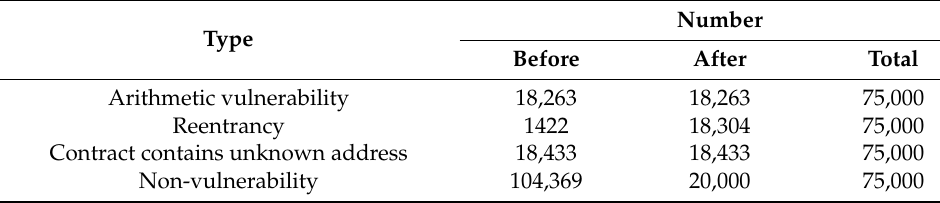
Figure 5. The number of vulnerability categories in the original datasets. Most of the contracts have non-vulnerability and the least number of contracts have reentrancy. Table 5. The number of positive and negative samples after